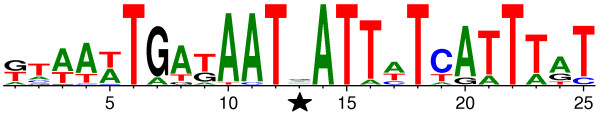
The optimized A. baumannii FUR motif. Per position, the size of the nucleotide (T in red, A in green, C in blue and G in black) indicates its prevalence in the 22 included sequences from Table 1. The motif shows a palindrome with a central non-conserved nucleotide in position 13 which is indicated by the star. The figure of the A. baumannii ATCC 17978 FUR motif was created using WebLogo 3.0 [64].